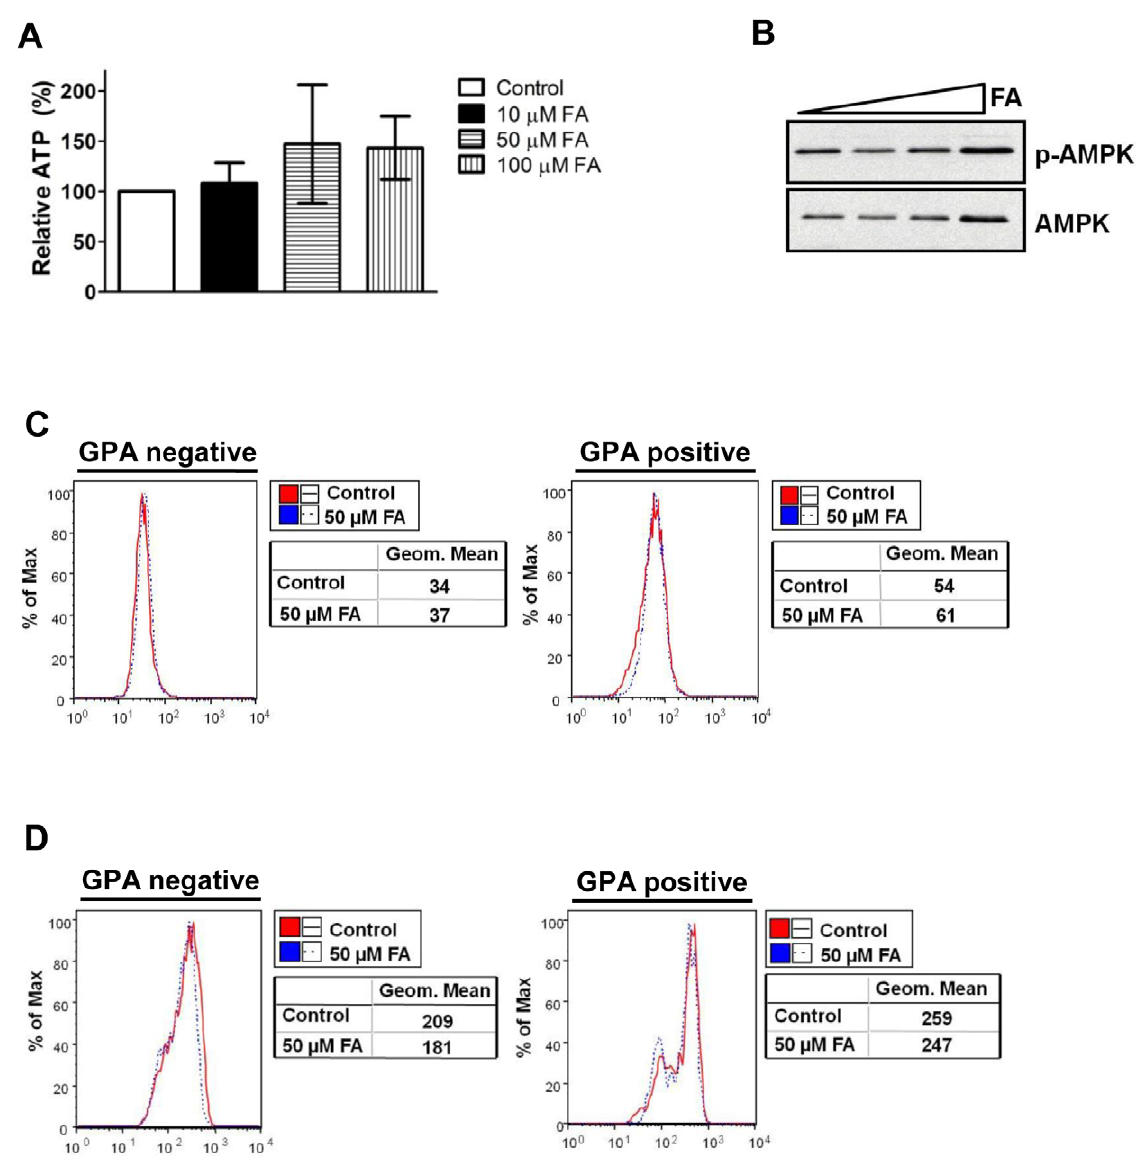
Figure 4. FA inhibits erythropoiesis in the absence of changes in cellular ATP, ROS, or MMP. ( A ) ATP levels in cells from day 5 erythroid cultures of human CD34 + progenitors treated with 0–100 m M FA. Shown are values relative to untreated cultures consisting of mean 6 SD from three independent experiments. ( B ) APMK activation in cells from day 5 erythroid cultures with 0–100 m M FA assessed by immunoblotting of whole cell lysates for phospho- and total AMPK. ( C ) Levels of reactive oxygen species (ROS) in cells from day 3 erythroid cultures 6 50 m M FA detected by the fluorescent probe APF. Mean fluorescence intensities (Geom. Mean) of the APF signal within GPA-negative and positive gates are shown adjacent to flow cytometry plots. ( D ) Mitochondrial membrane potential in cells from day 3 erythroid cultures 6 50 m M FA detected by MitoTracker CMXRos. Mean fluorescence intensities (Geom. Mean) of the MitoTracker signal within GPA-negative and positive gates are shown adjacent to flow cytometry